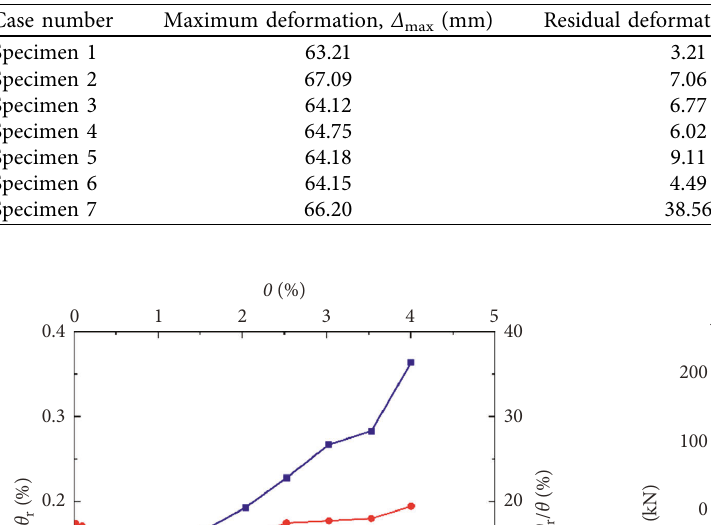
Table 7: The maximum deformation, residual deformation, and self-centering capacity coefficients in each test working case.